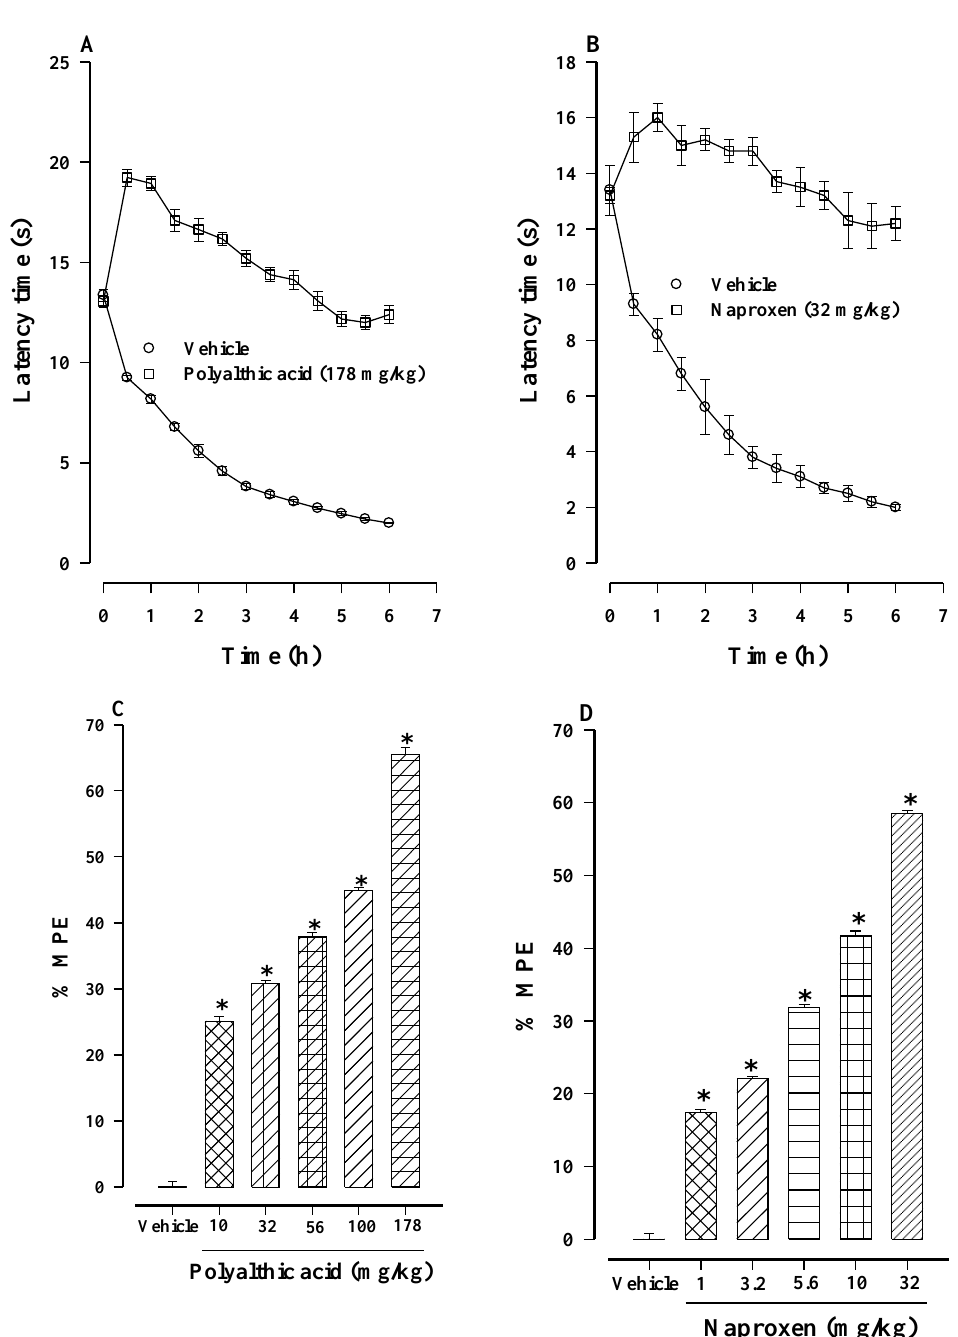
Figure 5. Temporal course of the antihyperalgesic activity of ( A ) polyalthic acid (178 mg/kg) and ( B ) naproxen (32 mg/kg). Hyperalgesia was induced by injecting 1% carrageenan into the left hind paw of rats. Data are expressed as latency time (in seconds) to withdraw the swollen paw from the heated surface. A dose-dependent effect was produced by orally administering: ( C ) polyalthic acid at 10 to 178 mg/kg and ( D ) naproxen at 1 to 32 mg/kg. Data are expressed as a percentage of activity against hyperalgesia, considering the maximum possible effect (% MPE). The ED 50 was calculated by linear regression. Bars represent the mean ± SEM ( n = 6). * p < 0.0001 vs. the vehicle-treated rats injected with carrageenan, as determined by one-way ANOVA and the Student–Newman–Keuls